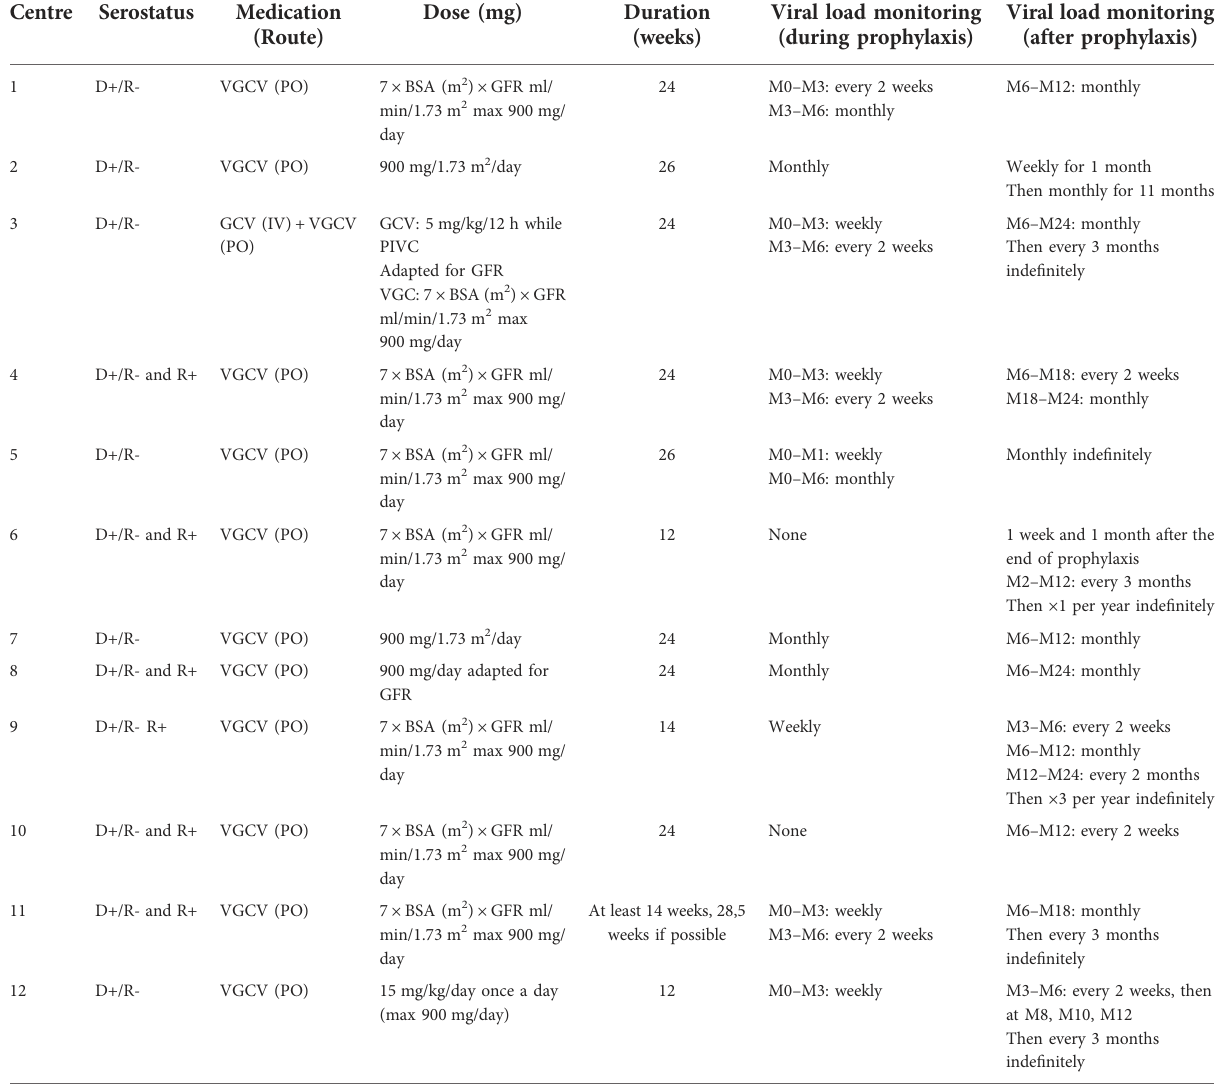
TABLE 2 CMV prevention strategies: prophylaxis summary. Centre Serostatus Medication Dose (Route)